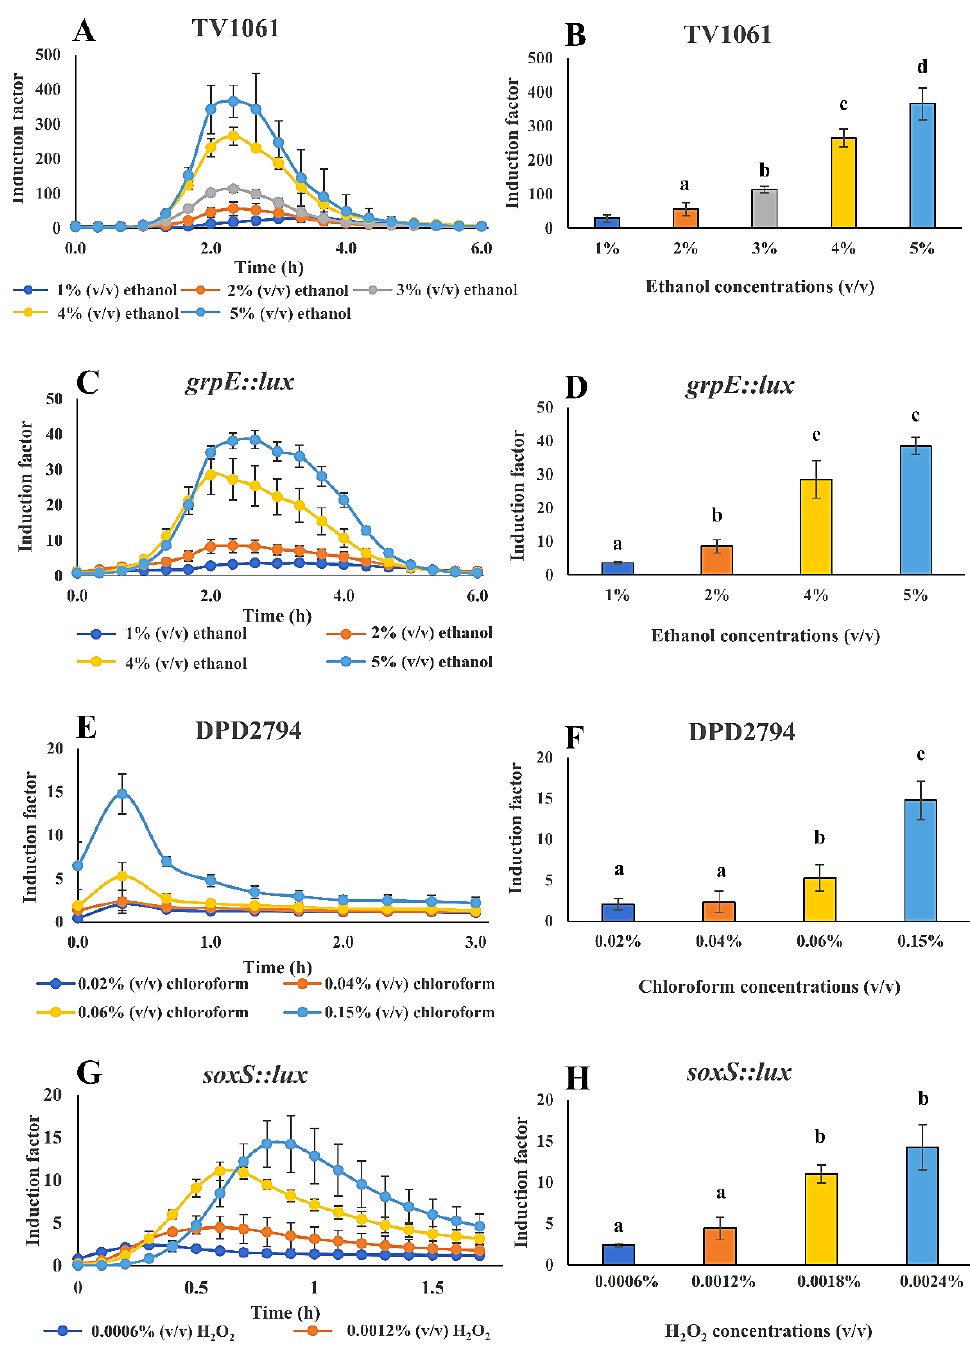
Figure 7. Whole-cell biosensor performance for the detection of toxicants in water samples using microplate reader for light signal detection. Detection of the following toxicants in spiked water samples: ( A – D ) Ethanol with TV1061 and grpE::lux ; ( E – F ) chloroform with DPD2794; ( G – H ) hydrogen peroxide (H 2 O 2 ) with soxS::lux . All the values in the graphs are presented as mean ± standard error of the mean (SEM), with different letters above the bars that indicate significant differences ( p < 0.05), which were tested by the Fisher's Least Significant Difference.